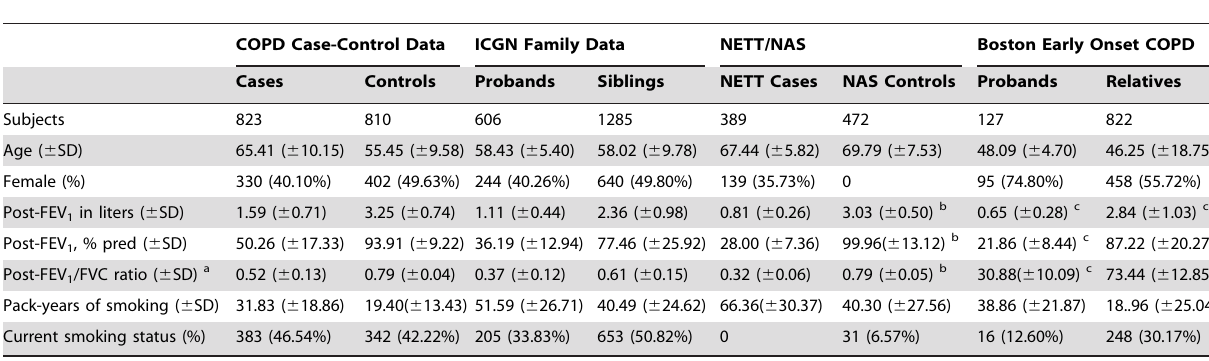
Table 1. Characteristics of the primary screening and replication